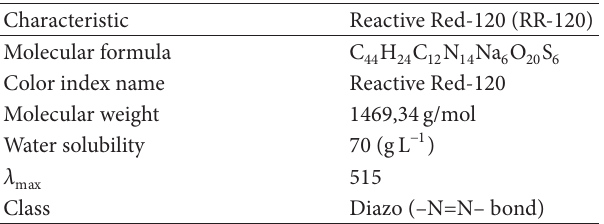
T 1: Some characteristics of the investigated